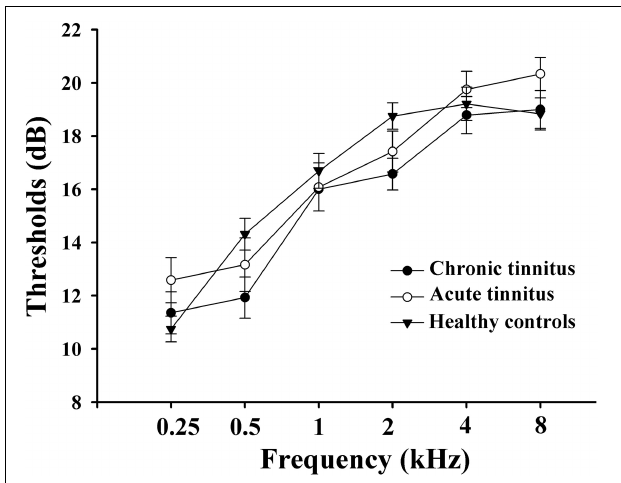
FIGURE 1 | Mean hearing thresholds of the chronic tinnitus, acute tinnitus, and healthy controls. Data are presented as mean ± SEM.